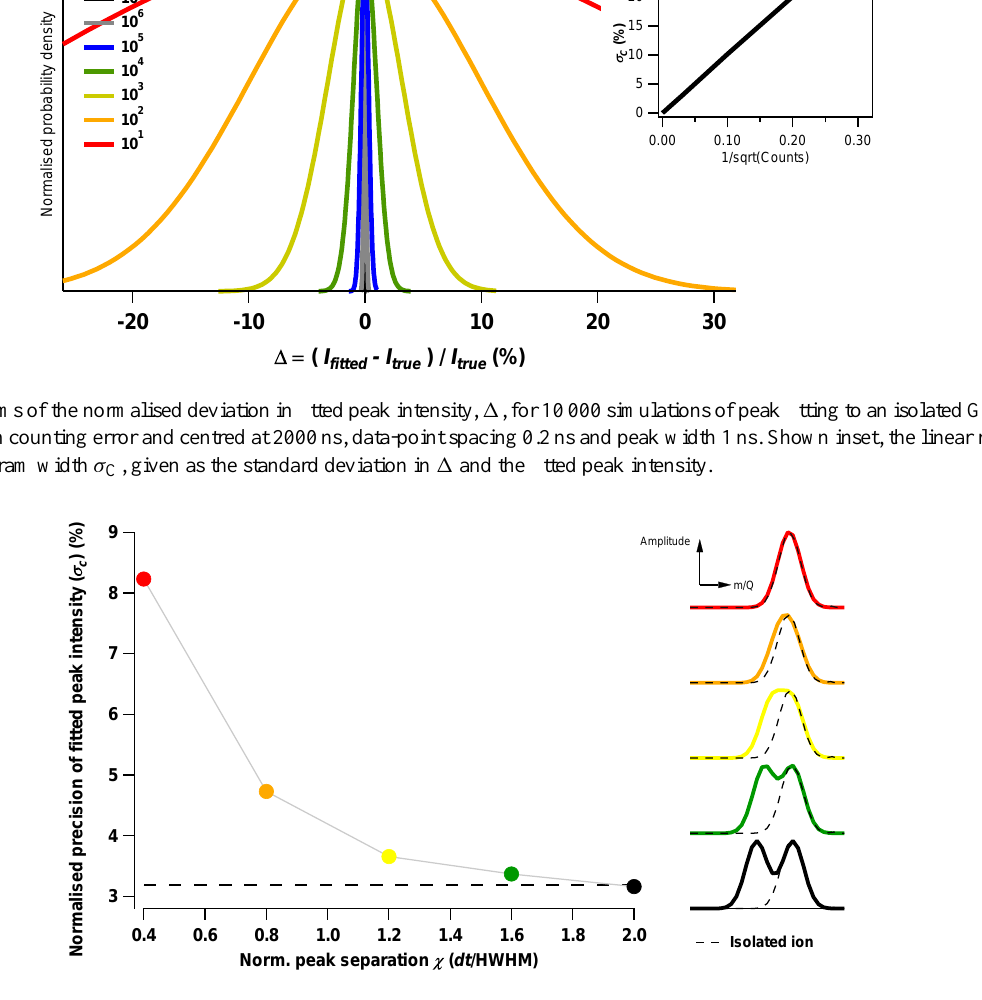
Figure 2. Relative precision in fitted peak intensity, σ C , for 10000 simulations of peak fitting to a pair of overlapping Gaussian peaks degraded with counting error. Peak intensity = 1000 counts; peak width = 1ns; peak centre = 2000ns; and point spacing = 0.2ns. Schemat- ics demonstrating the appearance of the measurement distributions are shown on the right, with dashed lines showing the measurement distribution of an isolated ion for